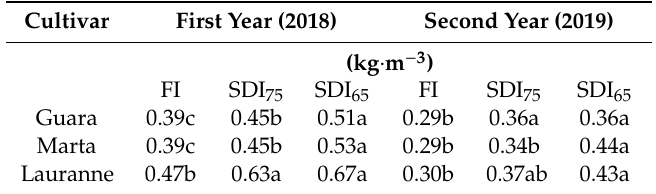
Table 3. Irrigation-water productivity (IWP, kg · m − 3 ) in each cultivar, treatment and studied year.